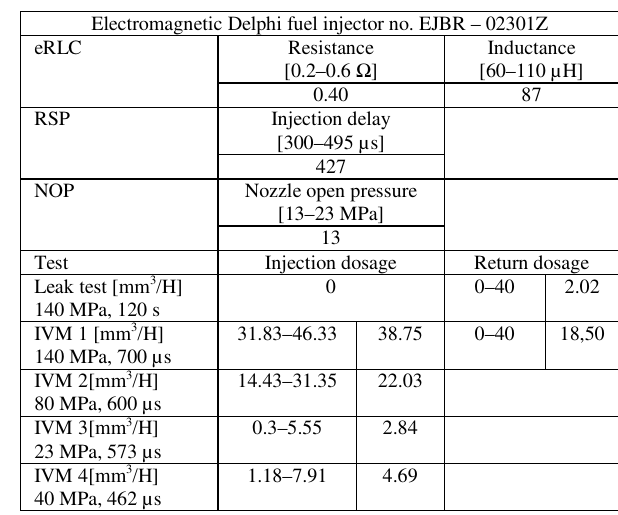
Table 7. Test results of faultless electromagnetic Delphi fuel injector research